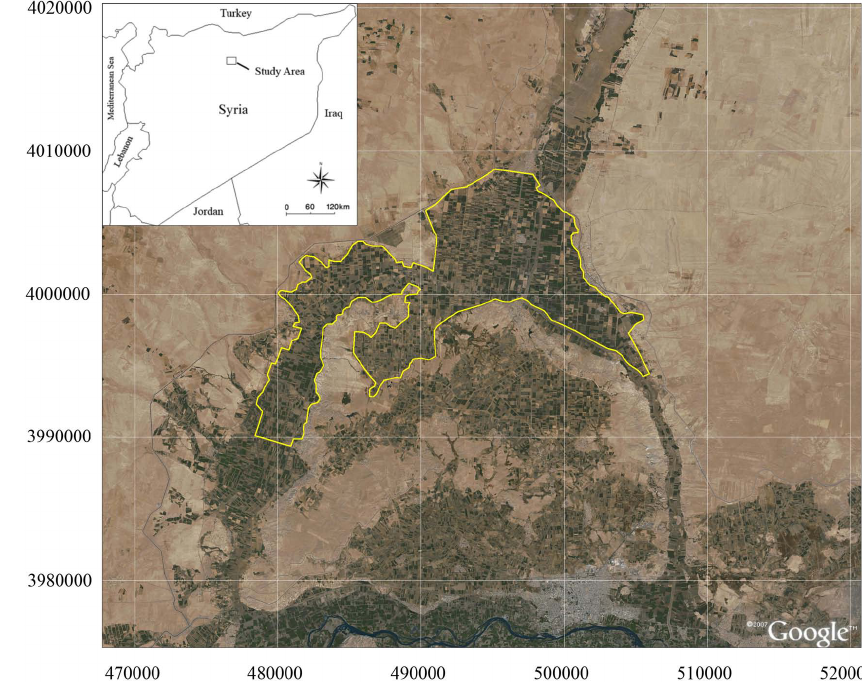
Fig. 1. Study area location within Al-Balikh river basin in northern of Syria (Google Earth image).